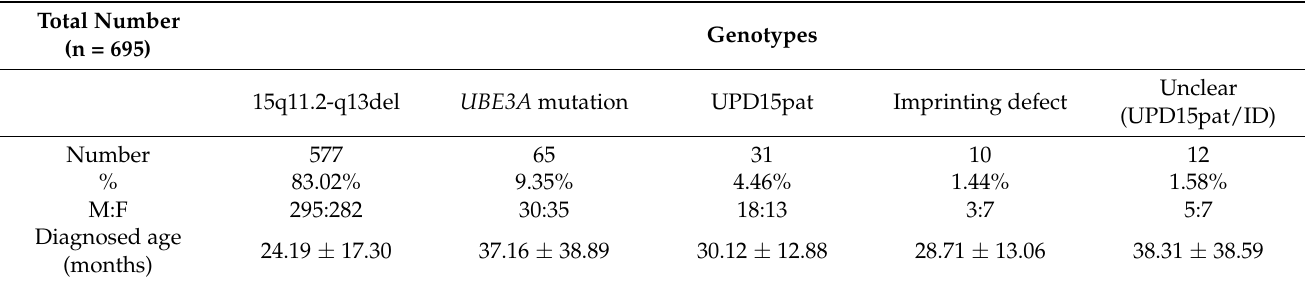
Table 1. Pattern of underlying genetic mechanisms for AS in our